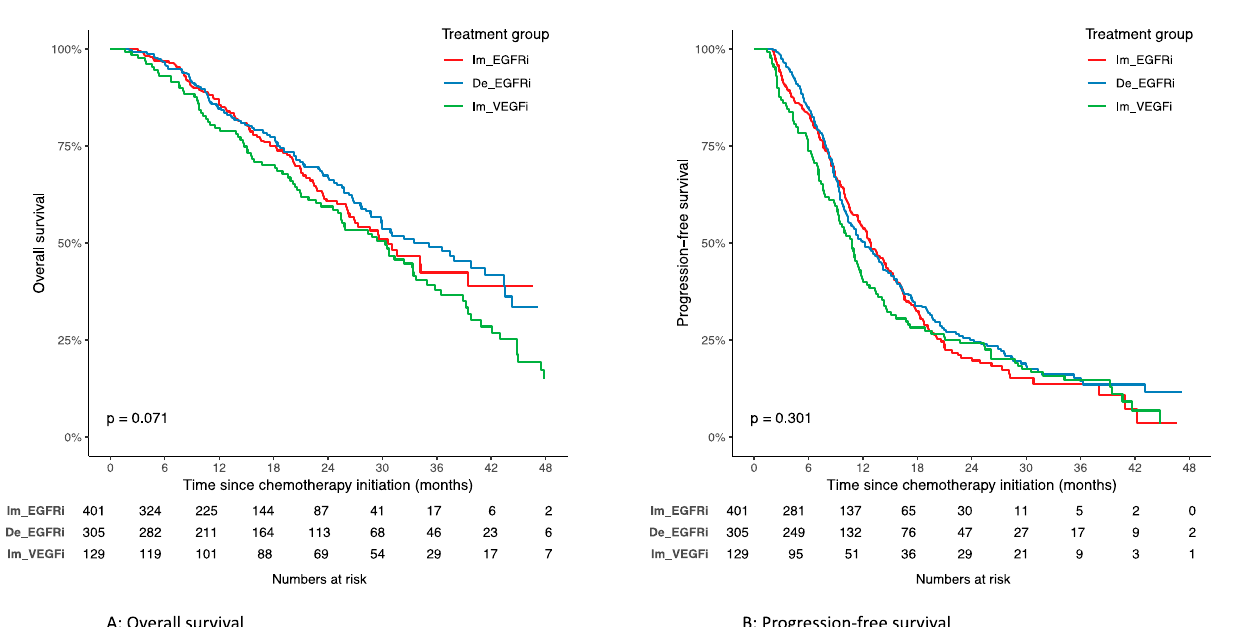
Figure A1. Survival according to treatment groups in the unweighted study population. ( A ) Overall survival; ( B ) progression-free survival. Im_EGFRi = immediate anti-EGFR; De_EGFRi = delayed anti-EGFR; Im_VEGFi = immediate anti-VEGF.